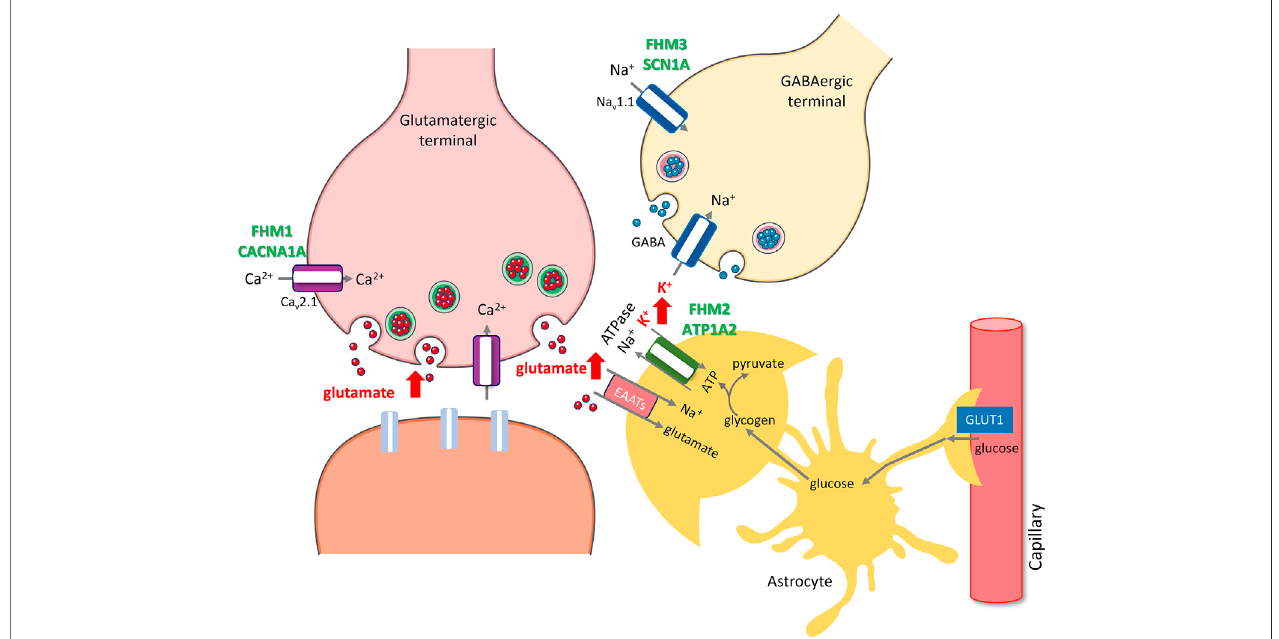
FIGURE1| RisesinextracellularglutamateandK+causedbyionchannelandtransportermutationsortranscriptionalchangesinducedbymigrainetriggerscreate susceptibilitytomigrainewithaura.Facilitationofexcitatorysynaptictransmissionbyeitherpromotingglutamaterelease(redarrows)duetogainoffunctionmutationsin P/Qtypepresynapticcalciumchannels(purple)encodedbyCACNA1AinFHM1ordecreasingitsuptakealongwithK+(redarrow)duetomutationsinalpha2subunitof Na+/K+ATPase(green)encodedbyATP1A2inFHM2,increasessusceptibilitytoCSDandmigrainewithaura.Glutamatereleasedduringsynapticactivityistaken up to astrocyte processes (amber) by excitatory amino acid transporters (pink, EAATs), which is driven by the Na + gradient created by Na+/K + ATPase, hence, glutamate and K+ uptakes are coupled. Excess K+ released from overactive GABAergic terminals (red arrow) due to gain of function mutations in Na V 1.1 type sodium channels(blue)encoded bySCN1AinFHM3alsocreatessusceptibilitytoCSDandmigrainewithaura.Glycogengranulesinperi-synapticastrocyte processesinstantly provide glycosyl units to meet the rapidly escalating energy demand during excitatory synaptic transmission (e.g., by Na+/K + ATPase), whereas glucose transported from circulation to astrocytes via GLUT1 is primarily used in replenishing glycogen. Insuf fi cient glycogen breakdown due to transcriptional changes induced by migraine triggerssuchassleepdeprivation,whichpromoteglycogensynthesiswhilereducingglycogenbreakdown,hindersglutamateand K+uptake asseeninFHM2, creating susceptibility to CSD and migraine in non-familial common migraine. The illustration is prepared by Dr. Zeynep Kaya. Cellular templates are copied from Servier Medical Art